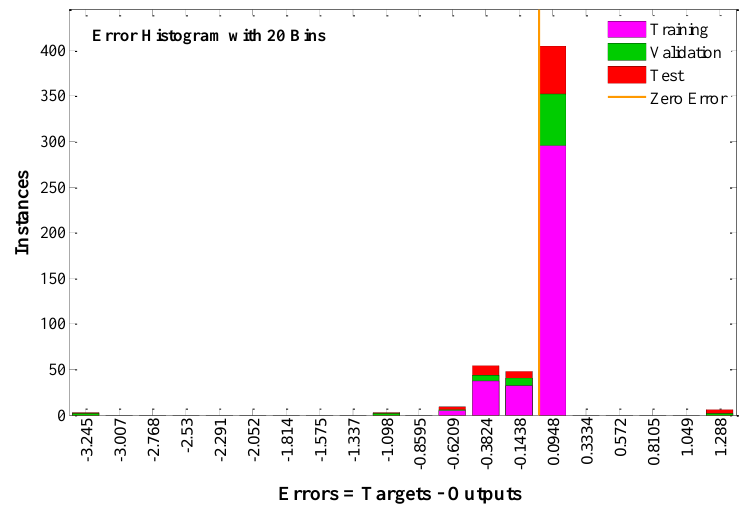
Figure 10. Error distribution diagram for electrical conductivity of nanofluids ( x -axis: difference of error value between experimental and predicted results, y -axis: number of data).